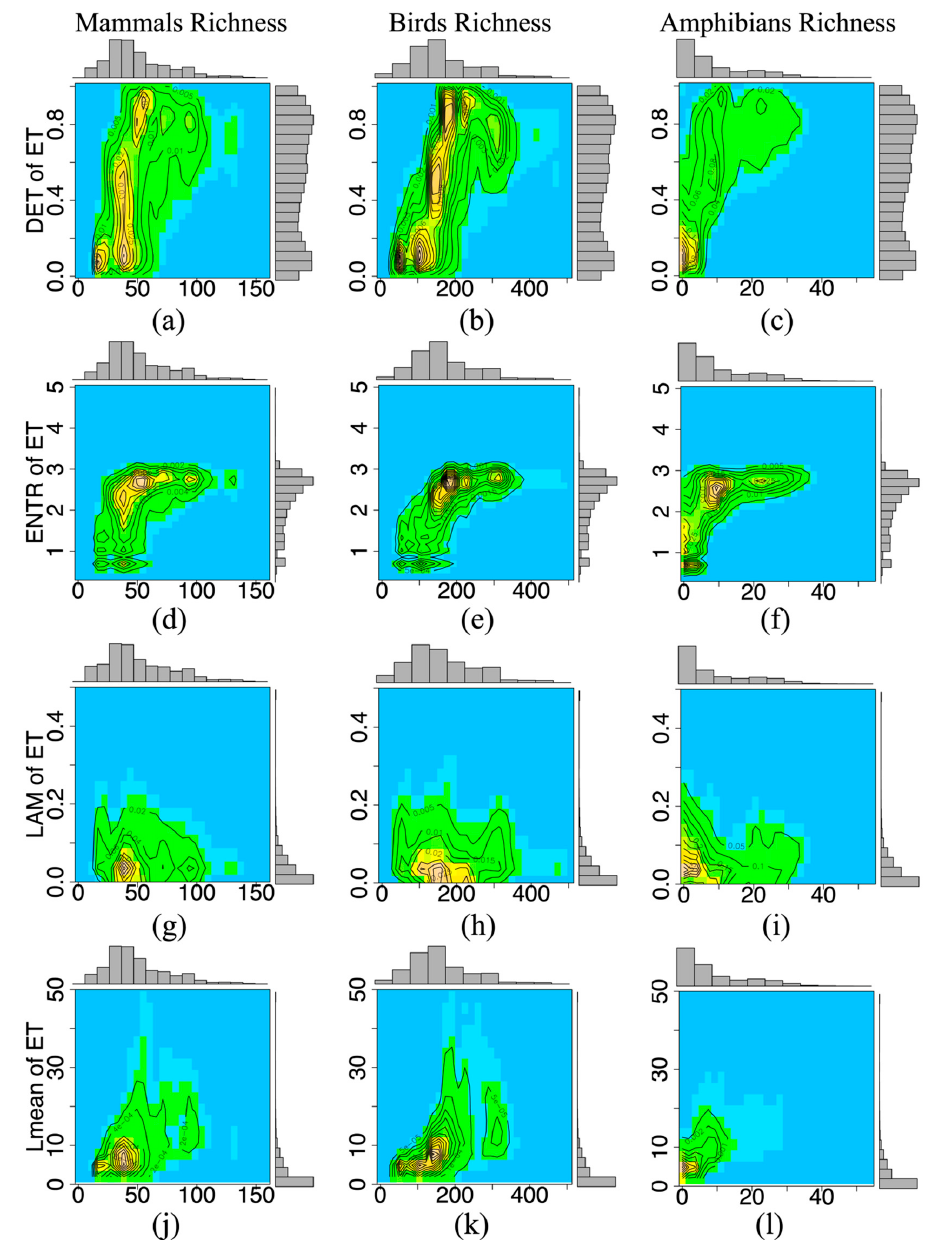
Figure 5. Frequency distribution between species richness from field surveys and the DET of long-term evapotranspiration (ET) are presented in (x,y)-format for ( a ) (Mammals, DET); ( b ) (Birds, DET); ( c ) (Amphibians, DET); ( d ) (Mammals, ENTR); ( e ) (Birds, RNTR); ( f ) (Amphibians, ENTR); ( g ) (Mammals, LAM); ( h ) (Birds, LAM); ( i ) (Amphibians, LAM); ( j ) (Mammals, Lmean); ( k ) (Birds, Lmean); and ( l ) (Amphibians, Lmean).